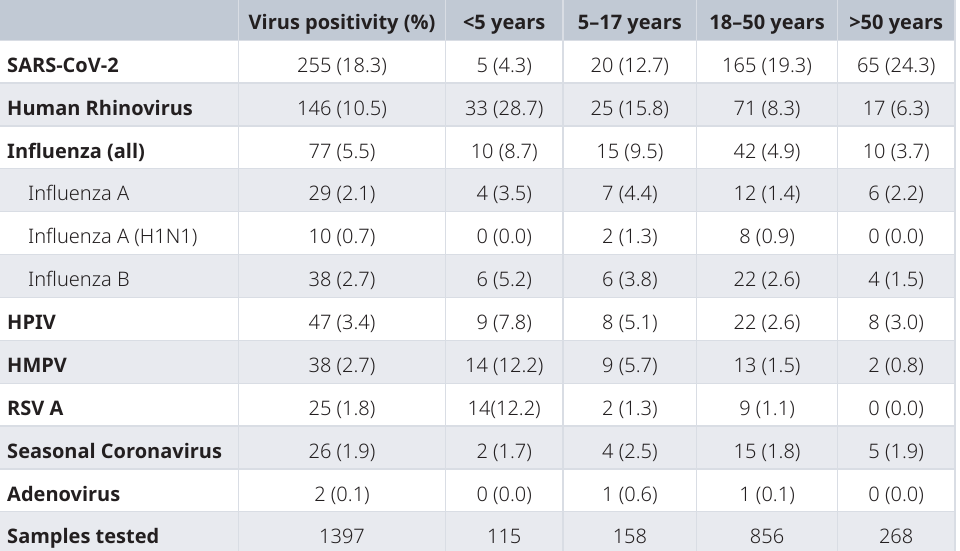
Table 2. Respiratory viruses detected during the study period stratified by age of participants. The denominator for virus positivity is total participants in the study (n=1397) or the number of participants recruited in each age group. RSV A = Respiratory Syncytial Virus A; HMPV = Human Metapneumovirus; HPIV = Human Parainfluenza viruses (pooled samples positive for HPIV1-4); Seasonal Coronavirus = combined 229E, NL63 and OC43 positive samples. Influenza A = samples positive for influenza A but negative in the pandemic H1N1 specific assay, which are presumed Influenza A H3N2, but not